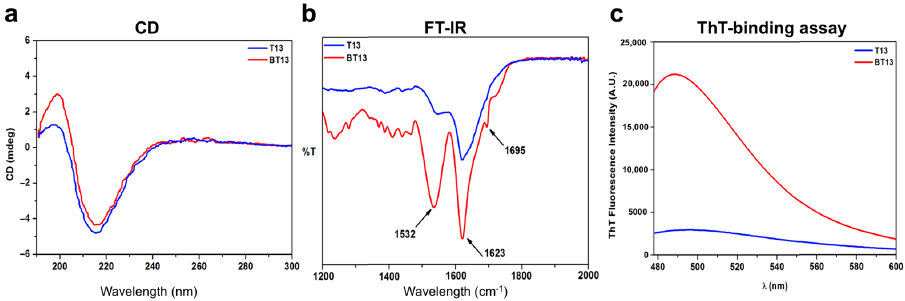
Figure 1. Supramolecular organization of T13 and BT13 peptide solutions. ( a ) Circular dichroism (CD) spectra of T13 (in blue) and BT13 (in red) suggesting the presence of β -sheet secondary structures. ( b ) FT-IR spectra of T13 and BT13 peptides with a characteristic β -hairpin conformation for T13, and typical anti-parallel β -sheet conformation for BT13 peptide. ( c ) ThT-binding assay of T13 and BT13 peptides, showing a high amyloid-binding emission signal (centered at 490 nm) of BT13 compared to T13 peptide.